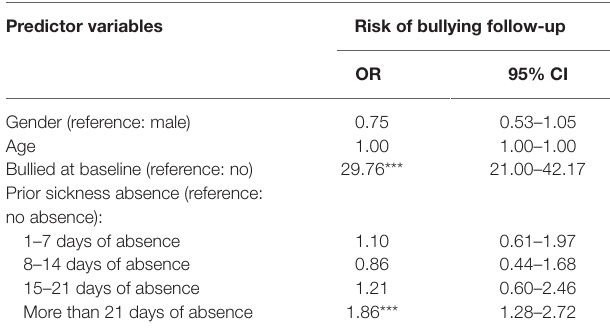
TABLE 2 | Logistic regression of associations between the risk of medically certified sickness absence during the previous 24 months as predictor variable and workplace bullying as outcome variable, adjusted for age, gender, and previous exposure to bullying ( N =